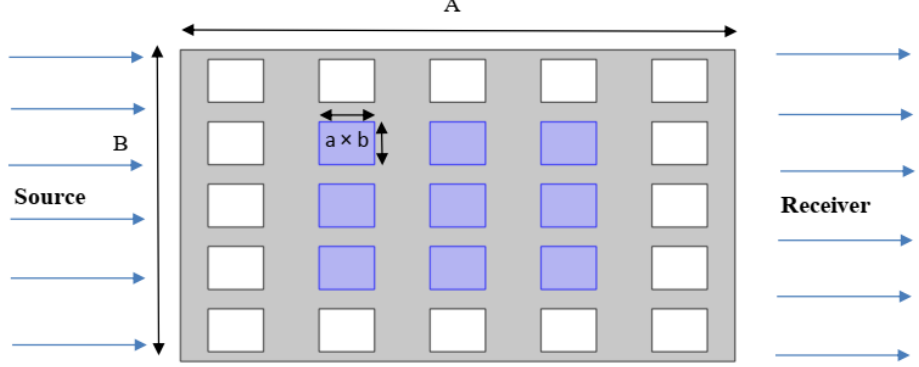
Figure 4. Structure of the unit cell under computational study with source and receiver surfaces. The empty white region indicates air voids, while the shaded purple rectangle indicates steel